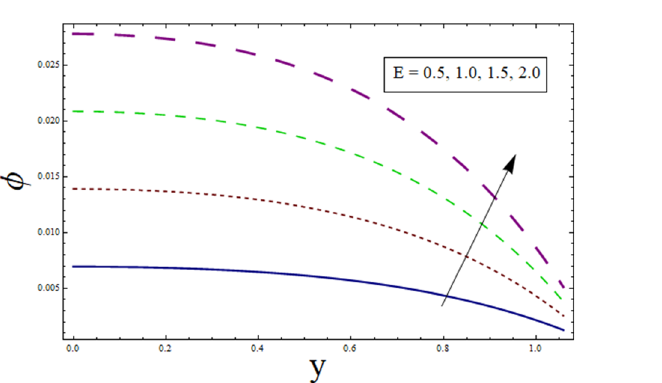
Figure 28. ϕ for E